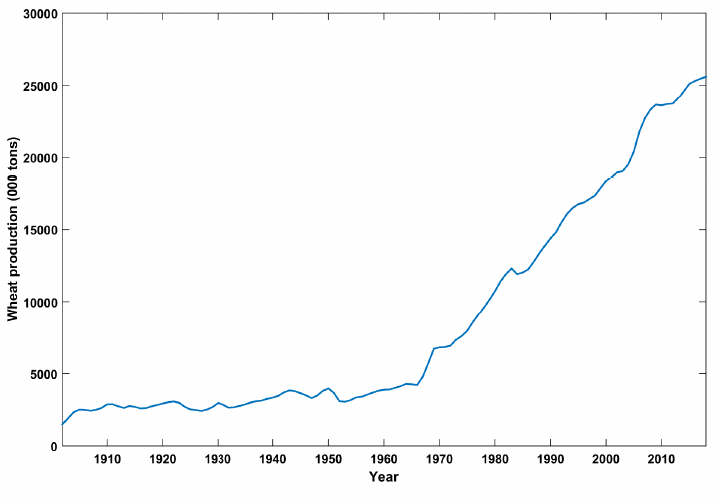
Figure 6. Wheat production curve after applying smoothing